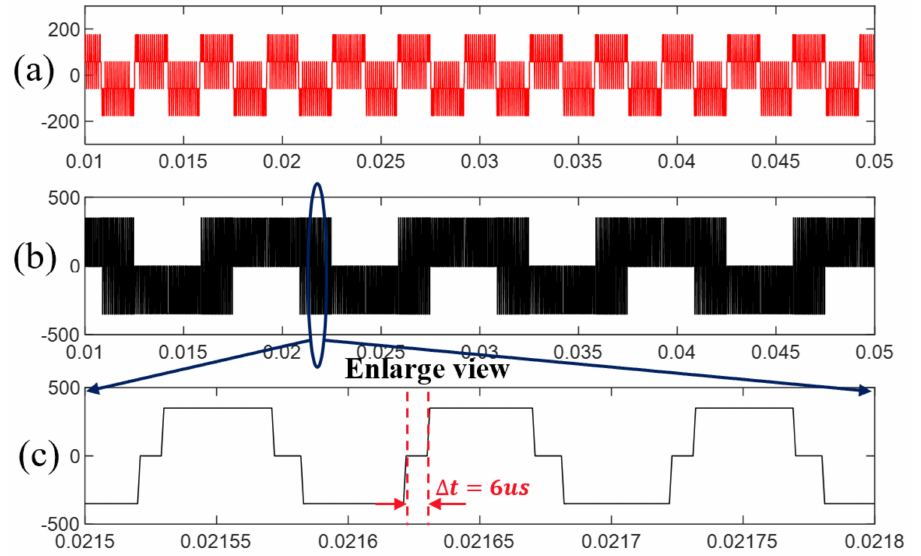
Figure 15. TSPWM with zero-voltage time interval optimization (M = 0.6): ( a ) common voltage; ( b ) line–line voltage; ( c ) enlarge view of line–line